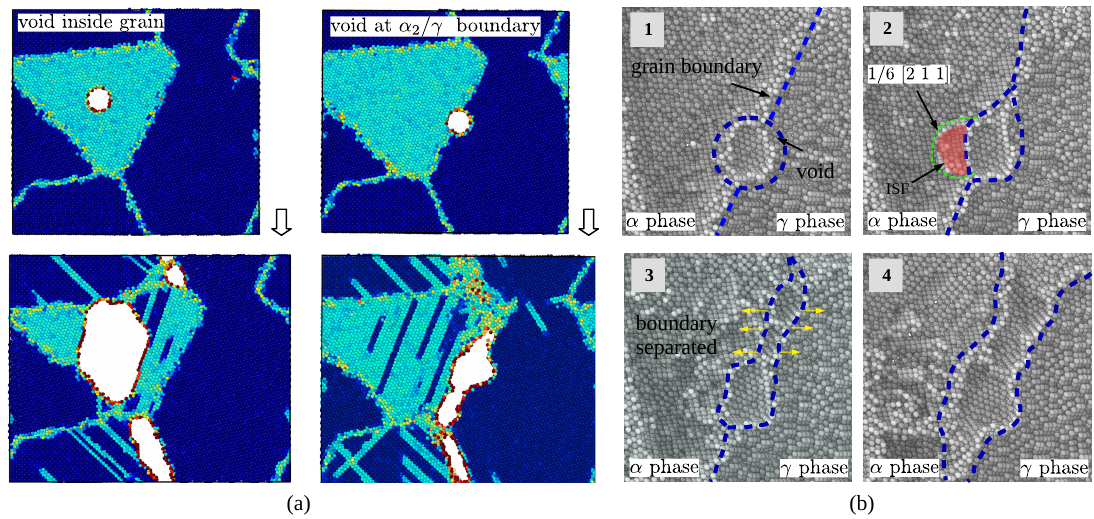
Figure 12. ( a ) Fracture mode of two types of mode; ( b ) Evolution of void at α 2 / γ phase